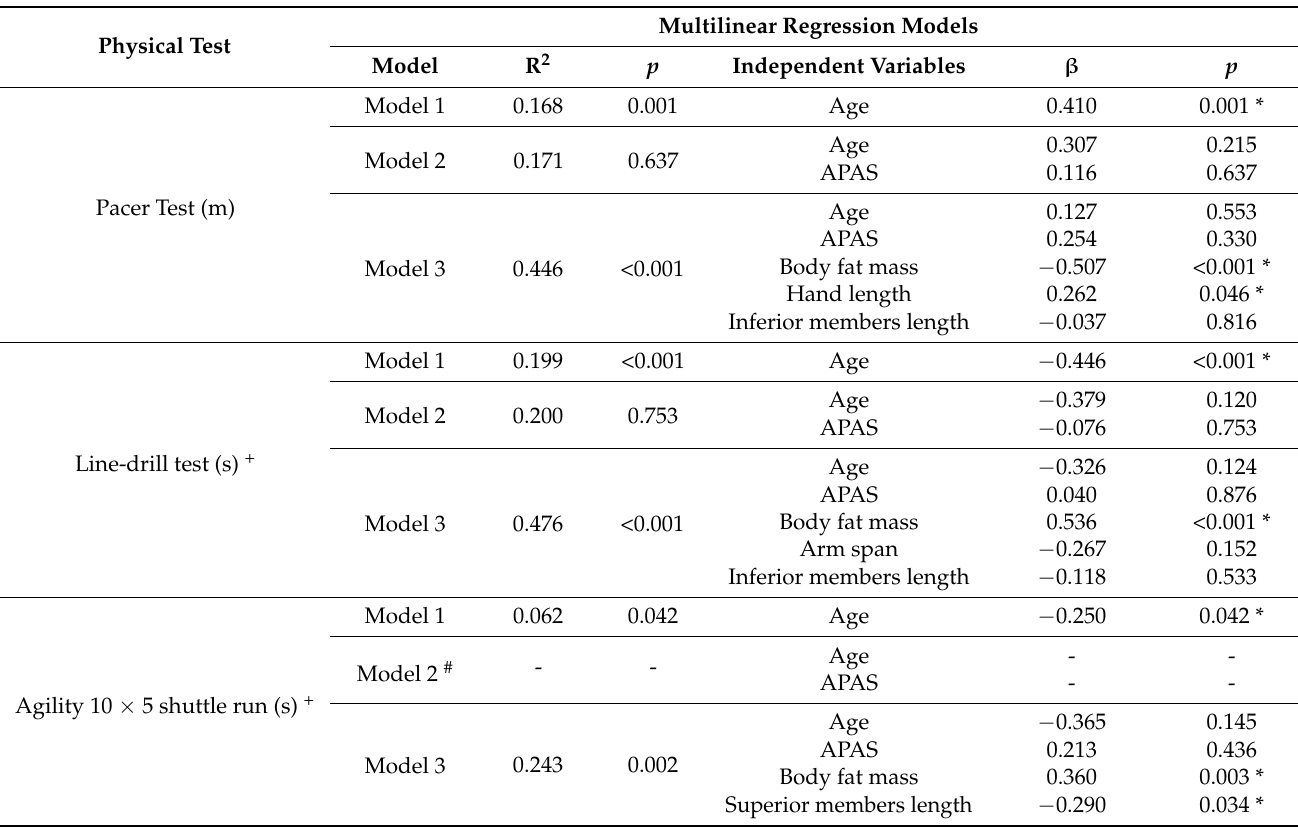
Table 3. Hierarchical multiple linear regression models for physical performance tests (aerobic, anaerobic, and agility) in youth male